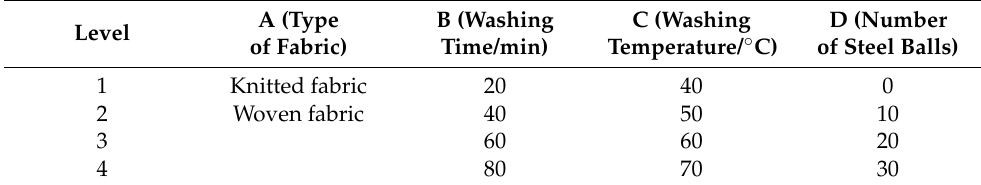
Table 3. Level of factor for fabric type and washing conditions.